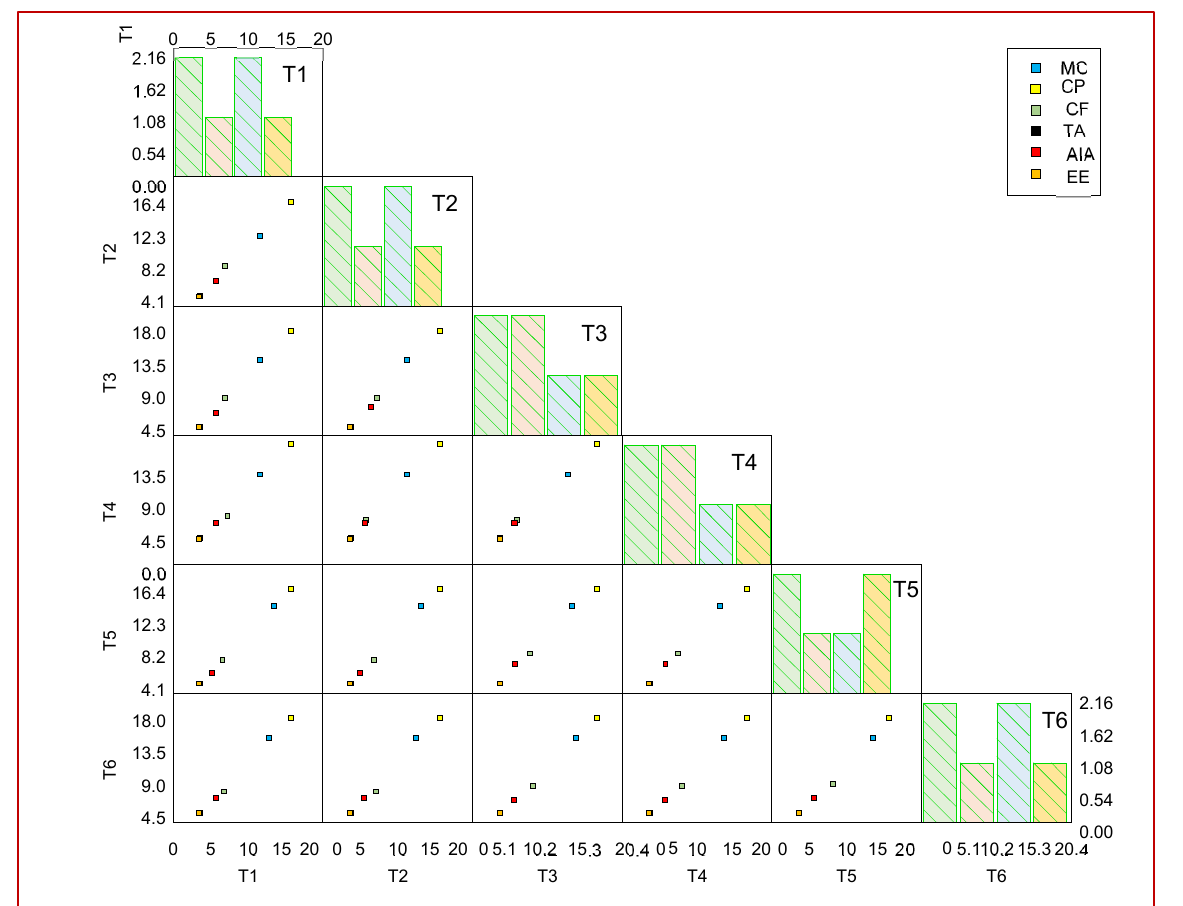
Figure 5. Scatter plots of variable correlation displayed in a matrix for different treatments and proximate constituents. Values are expressed as mean ± SD (n = 5) with a level of significance at p < 0.05. Abbreviations: DM: Dry matter; Moist: Moisture; CP: Crude protein; CF: Crude